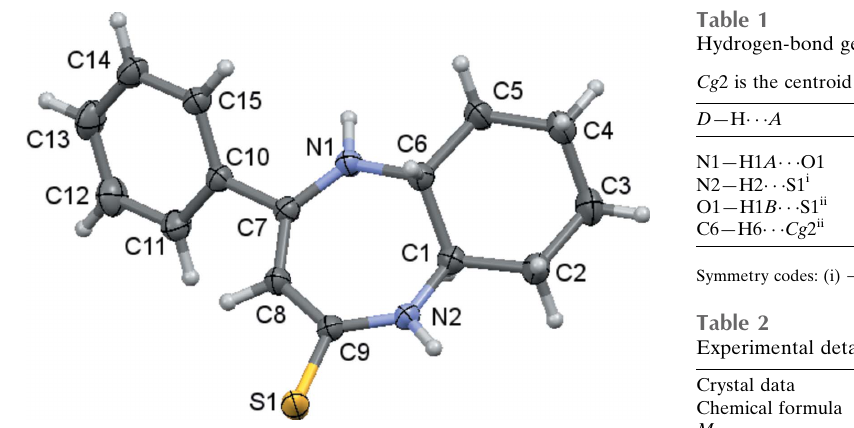
Figure 1 The title molecule with 30% probability ellipsoids. The disordered solvent molecule is omitted.